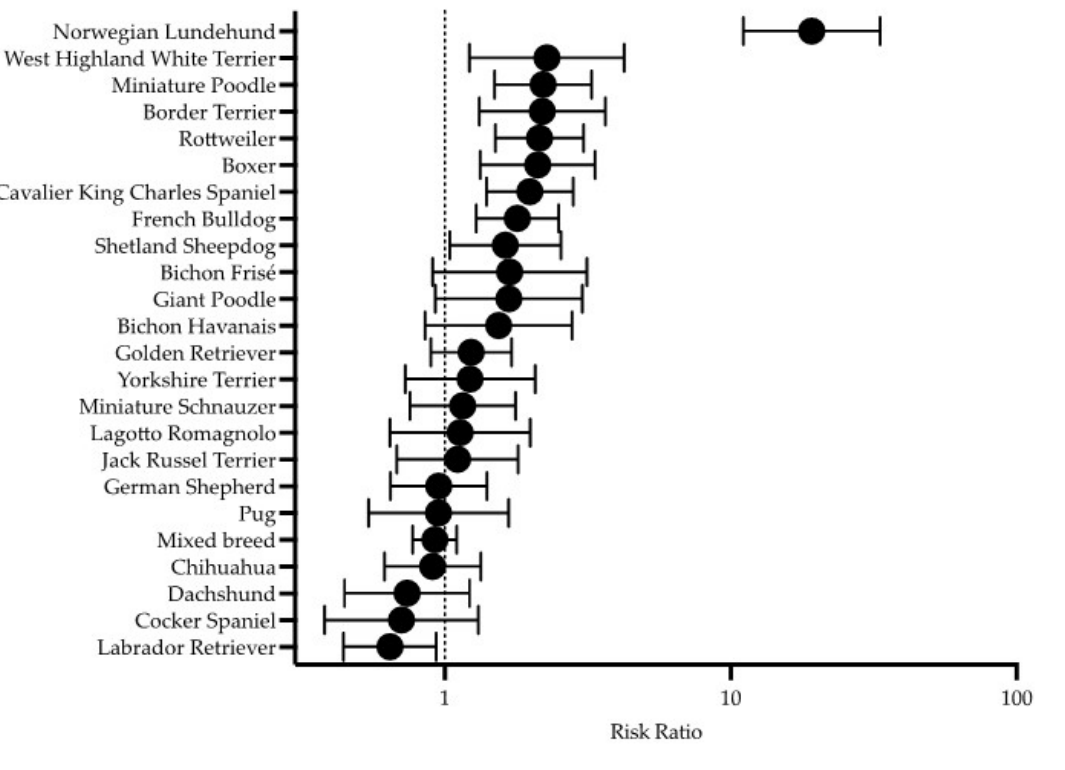
Figure 2. Forest plot showing the relative risk of chronic enteropathy (CE) and 95% confidence intervals breeds represented by ≥10 dogs in the dataset. See statistical methods for details and notice the logarithmically transformed x -axis.